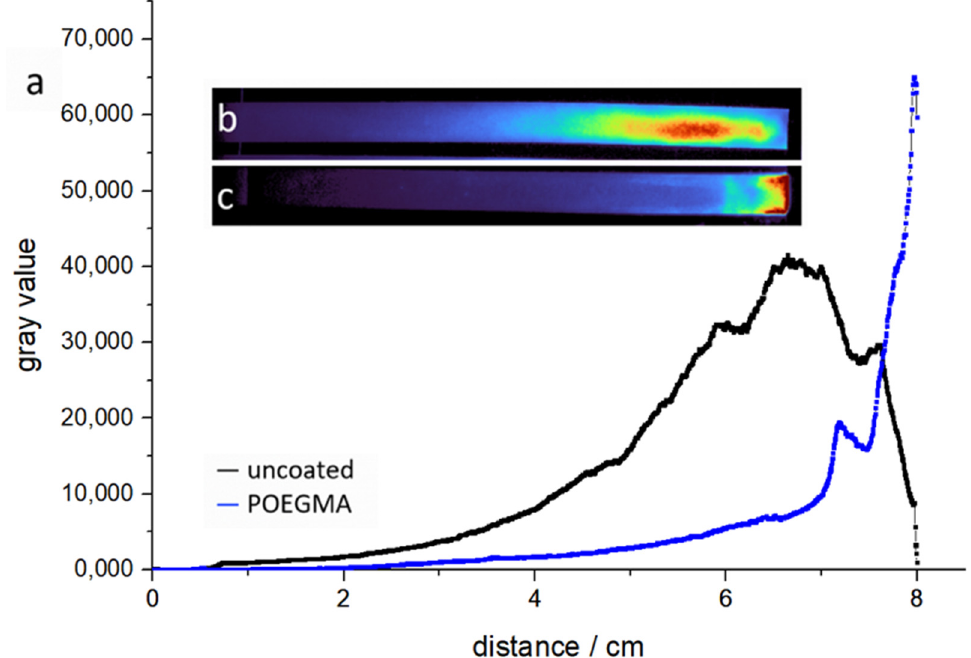
Figure 11. A comparison of uncoated and POEGMA-coated paper. In this experiment, GFP with a surface charge of +9 is applied in a “fully wetted flow” setup. The fluid was evaporated at 7.5–8 cm of the strip for 30 min once the strip was fully soaked. ( a ) The protein position across the strip by the means of gray values; ( b ) the fluorescent image of uncoated cotton linters. ( c ) The fluorescent image of POEGMA-coated cotton linters.